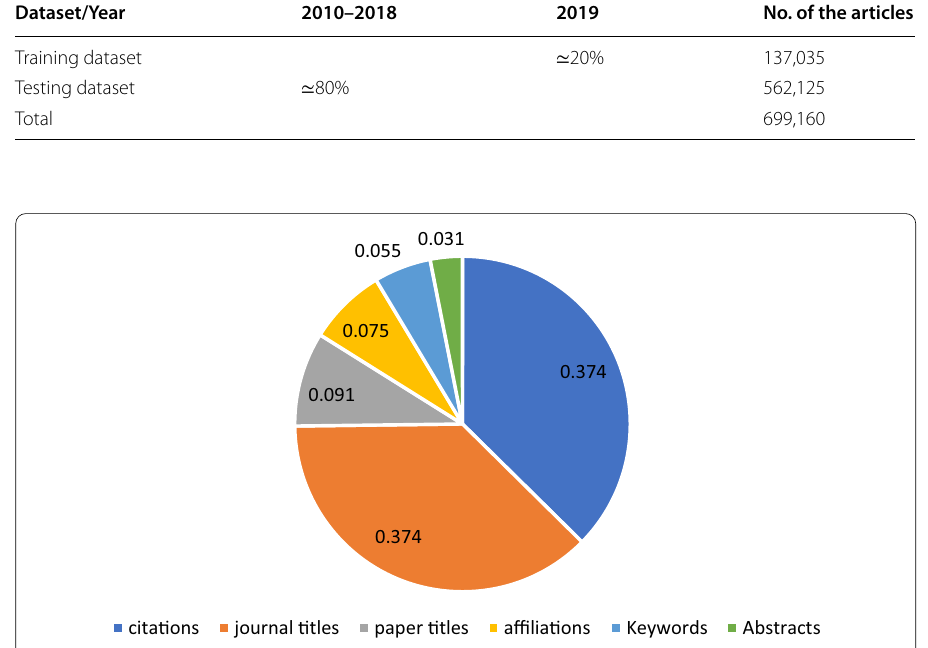
Fig. 1 The weights of the criteria using